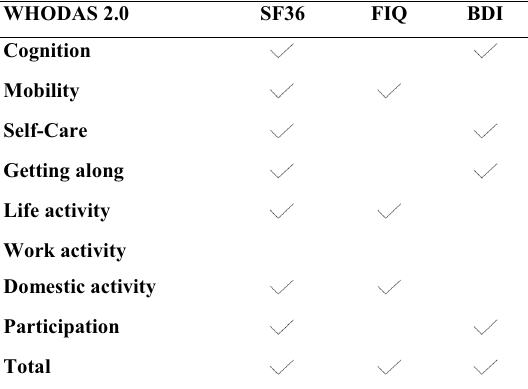
Table 1 Hypothesized correlations between the WHODAS 2.0 domains, total WHODAS 2.0 and the SF36, FIQ and